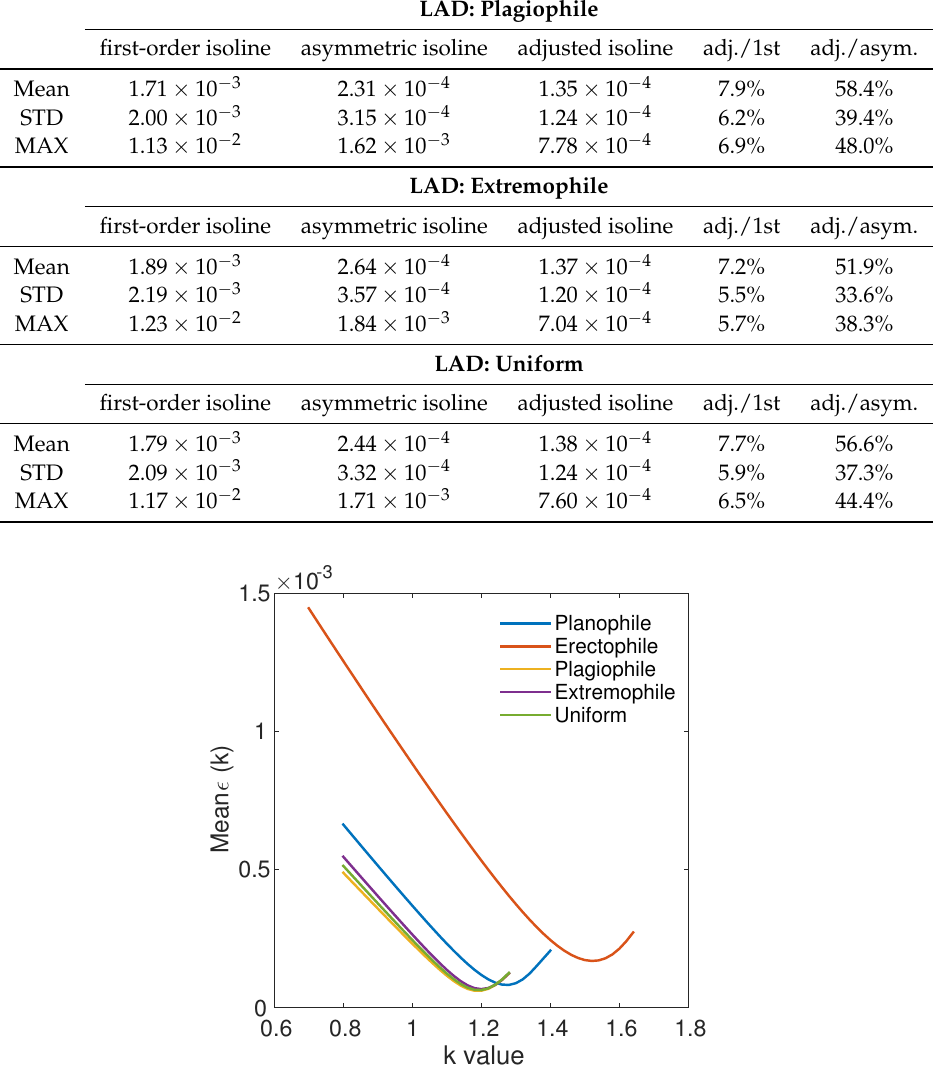
Figure 7. Plot of the mean (cid:101) as a function of the k -value for the planophile, erectophile, plagiophile, extremophile, and uniform LADs,